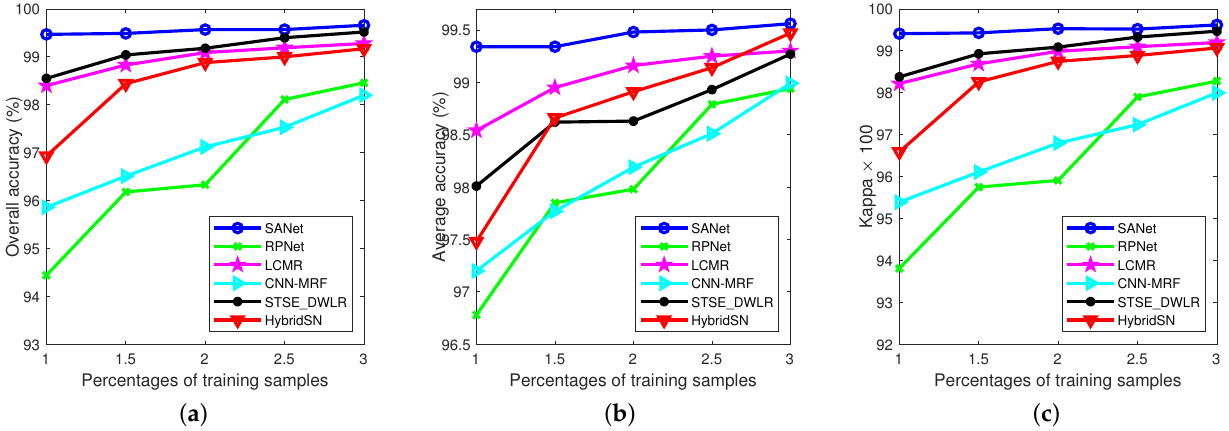
Figure 15. Experimental results of different methods with various numbers of training samples on Salinas data set. ( a ) OAs; ( b ) AAs; ( c ) κ